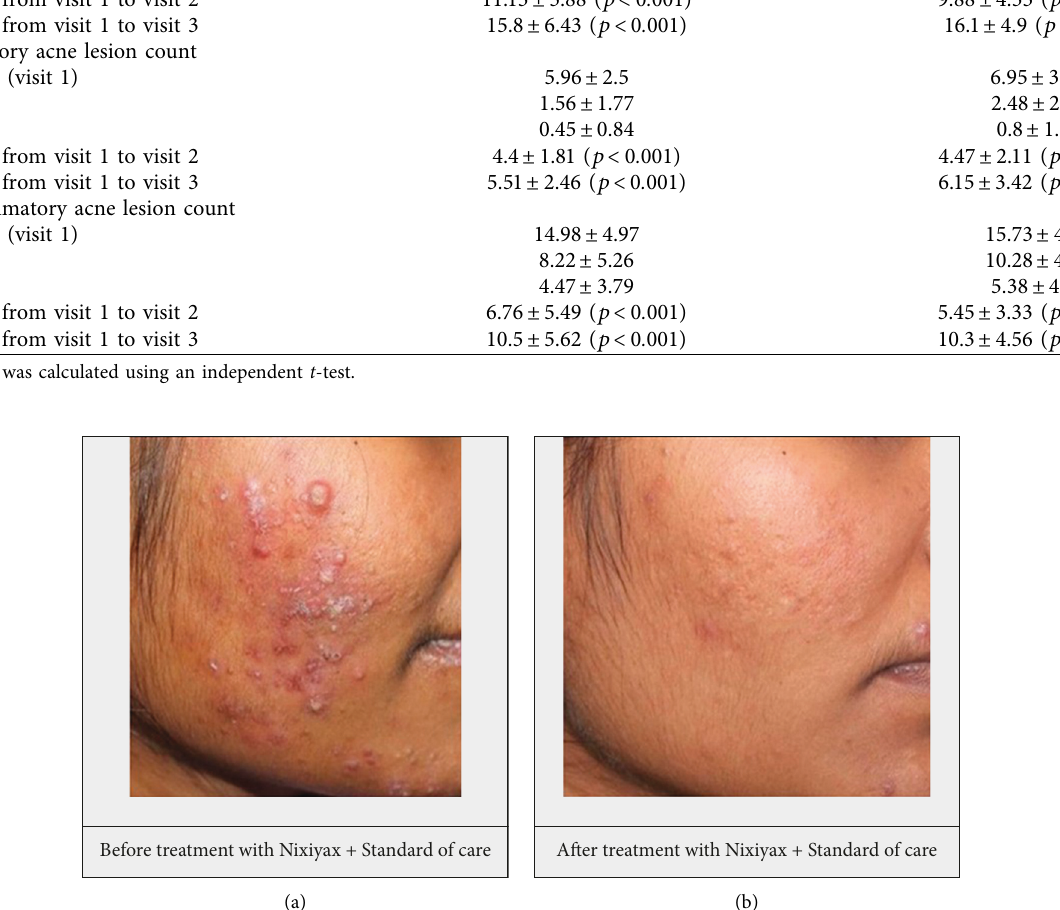
Figure 7: Treatment with Lactium ™ plus standard of care resulted in a decrease in inflammation, the number of acne lesions, and acne